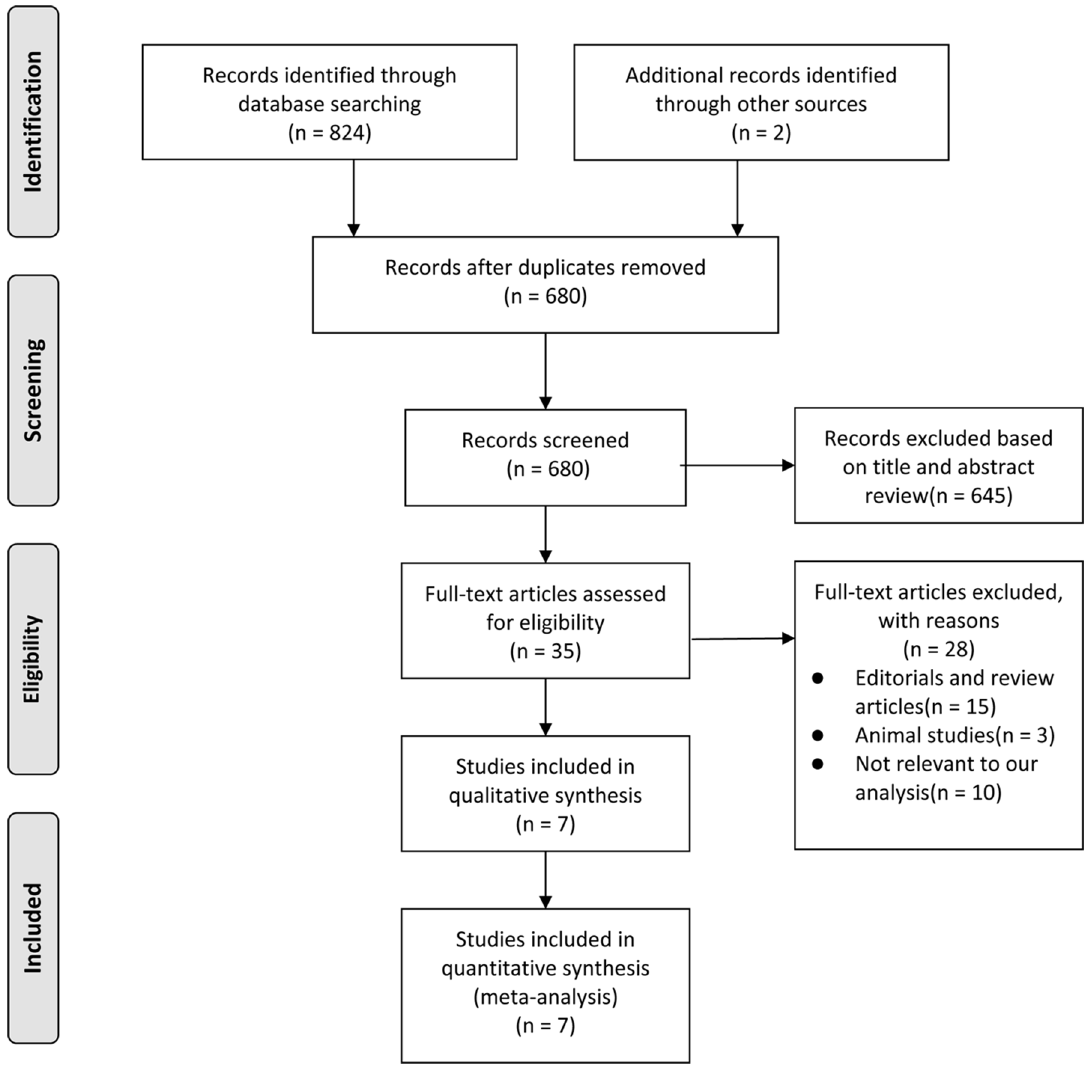
Figure 1. Flow diagram for selection of articles.